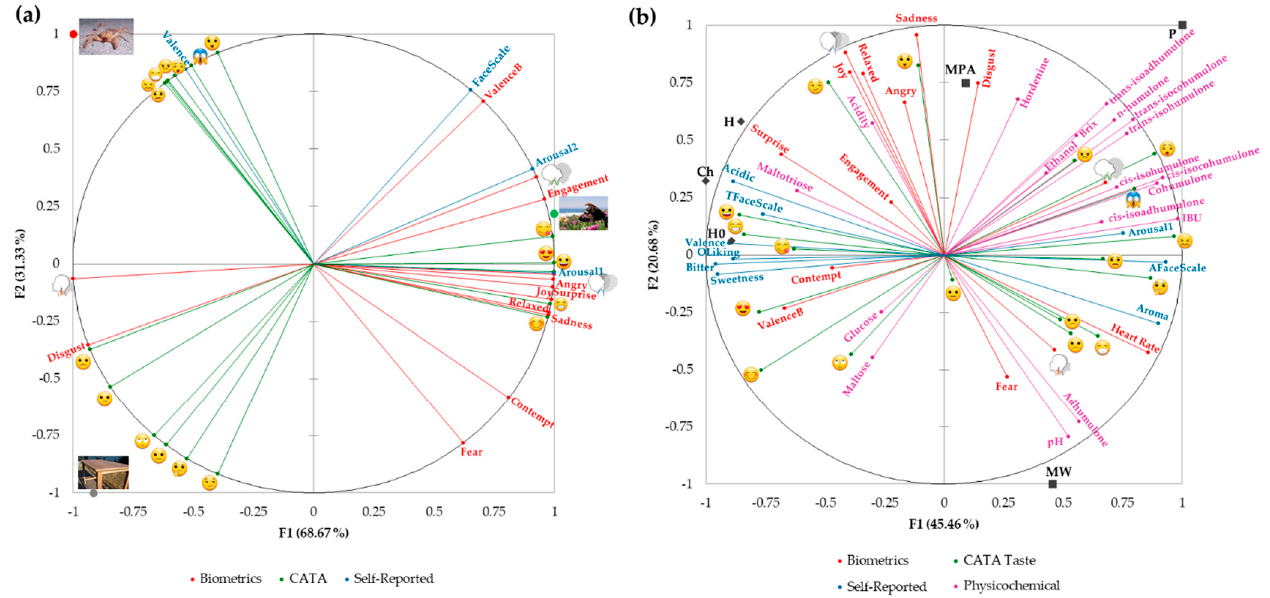
Figure 4. Multiple factor analysis (MFA) using the ( a ) check-all-that-apply (CATA) with emojis, self-reported and biometric responses from the Geneva Affective Picture Database (GAPED) images, and ( b ) physicochemical parameters, self-reported and biometric responses, and check-all-that-apply (CATA) with emojis from taste attribute evaluation of the beer samples. Abbreviations of the beer samples are found in Table 1. Other abbreviations: F1 and F2: factors 1 and 2; ValenceB: valence biometrics; AFaceScale: FaceScale from aroma; TFaceScale: FaceScale from taste; IBU: international bitterness units.